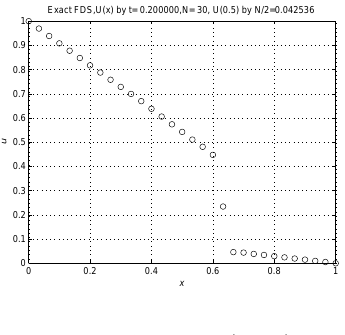
Figure 4. Solution T ( x, 0 . 2) with FDSES and N = 30.